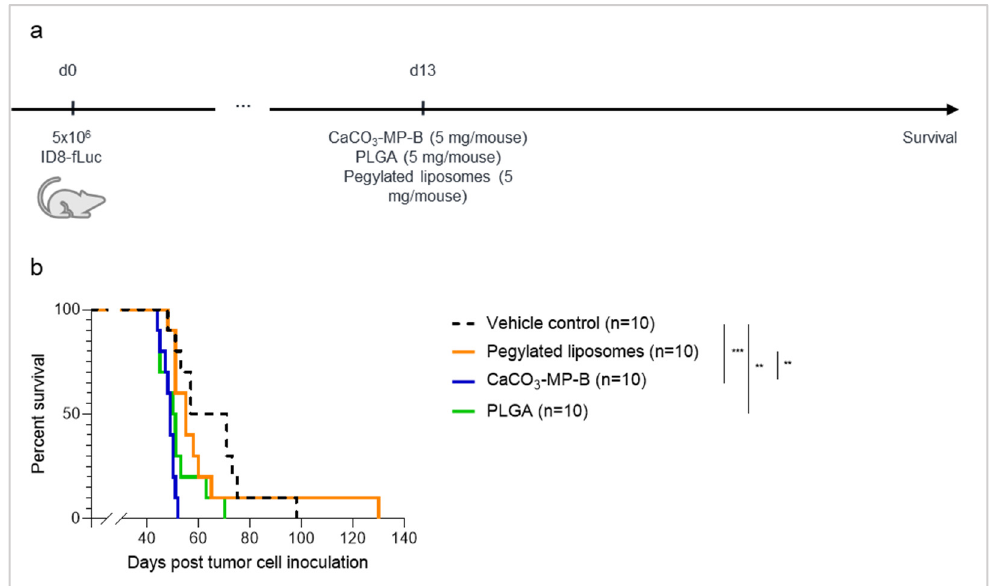
Figure 3. Experimental set-up of the experiment ( a ) with corresponding Kaplan–Meier survival curve ( b ) of mice injected with vehicle control, 5 mg of CaCO 3 -MP-B 5 mg PLGA or 5 mg pegylated liposomes on day 13 post tumor cell inoculation. The current data are obtained from the same experiment as the data that are found in Figure 6. ( b ): As a single treatment, CaCO 3 -MP-4 and PLGA have a shorter survival compared with vehicle control ( p adj = 0.0007 and p adj = 0.0095, respectively). Pegylated liposomes show a significantly better survival than CaCO 3 -MP-4 ( p adj = 0.0017). PLGA: polymer poly (lactic-co-glycolic acid). Degree of significance: p adj < 0.01 (**), p adj < 0.001 (***).